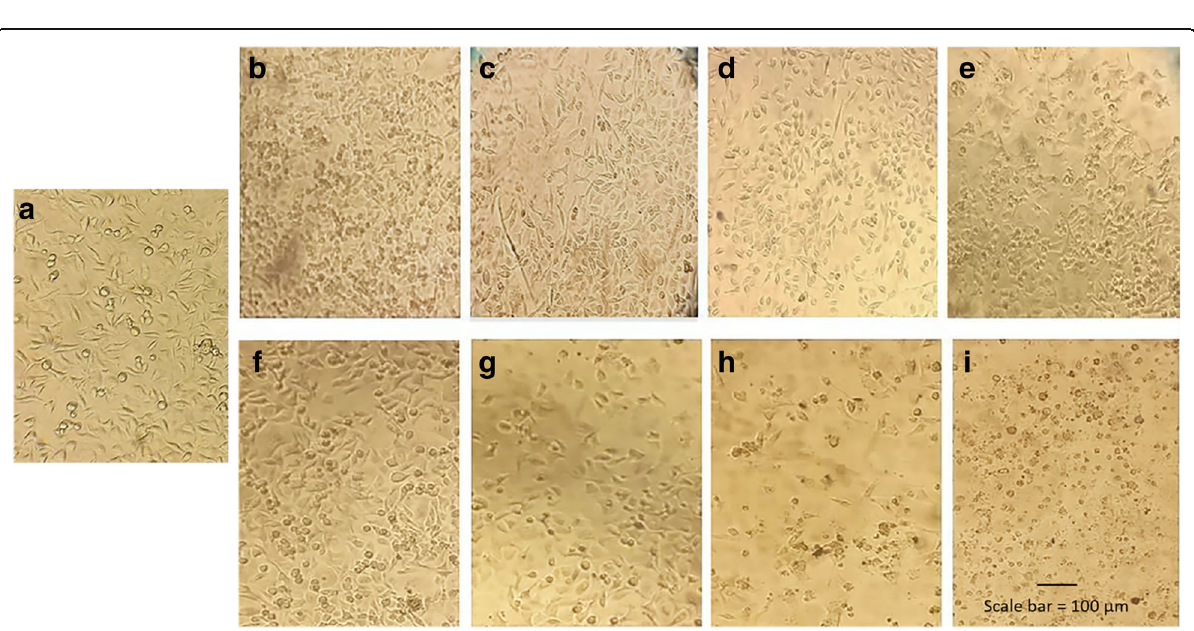
Fig. 7 Cell viability (MTT) assay after incubation of HeLa ( a ) and MDA-MB-231 ( b ) cells with peptide-f-GNRs (using different concentrations of peptide) compared with CTAB-GNRs after 24 h. Cell viability after incubation of HeLa cells with peptide-f-GNRs compared with CTAB-GNRs after 48 h ( c ). The results are expressed as percentages compared with untreated control cells and represent the mean and standard deviation (sd) of three independent experiments (*** P < 0.001)